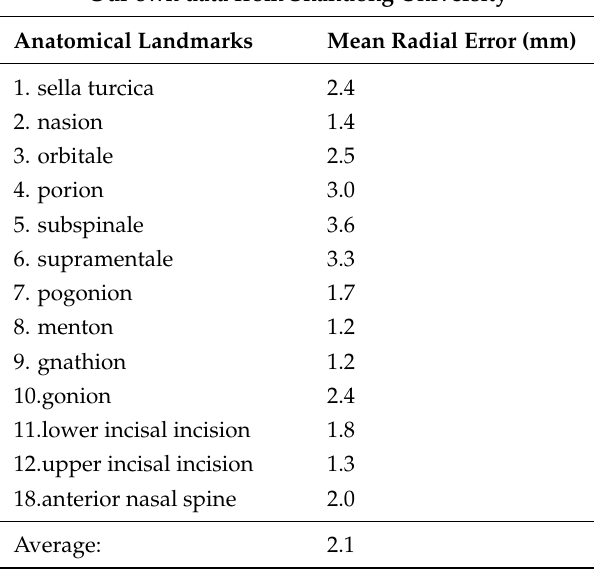
Table 5. Results of Mean Radial Error on our own